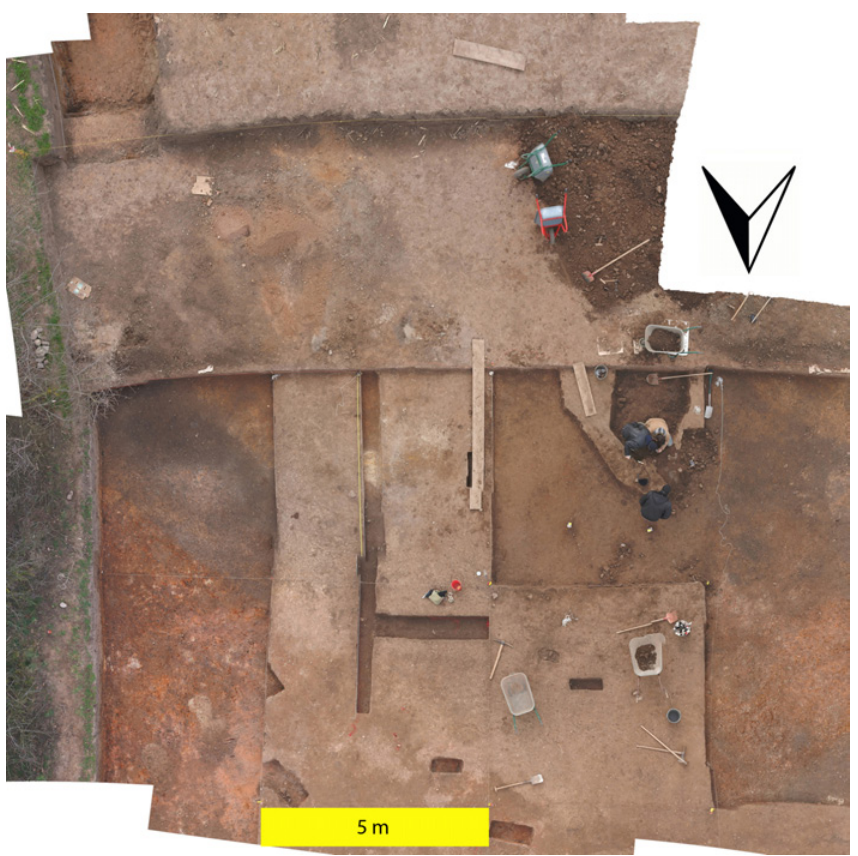
Figure 11: Part of the planum 3, Hassloch,